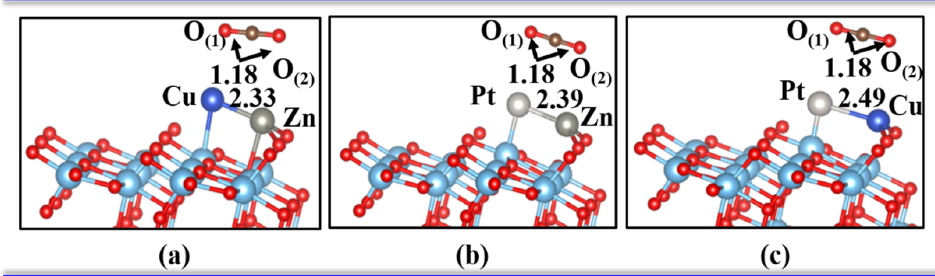
Figure 3. One CO 2 molecule absorbed on the surface of the bimetal-TiO 2 (101) system from a side view. ( a – c ) are Cu ‐ Zn, Pt ‐ Zn and Pt ‐ Cu, respectively.